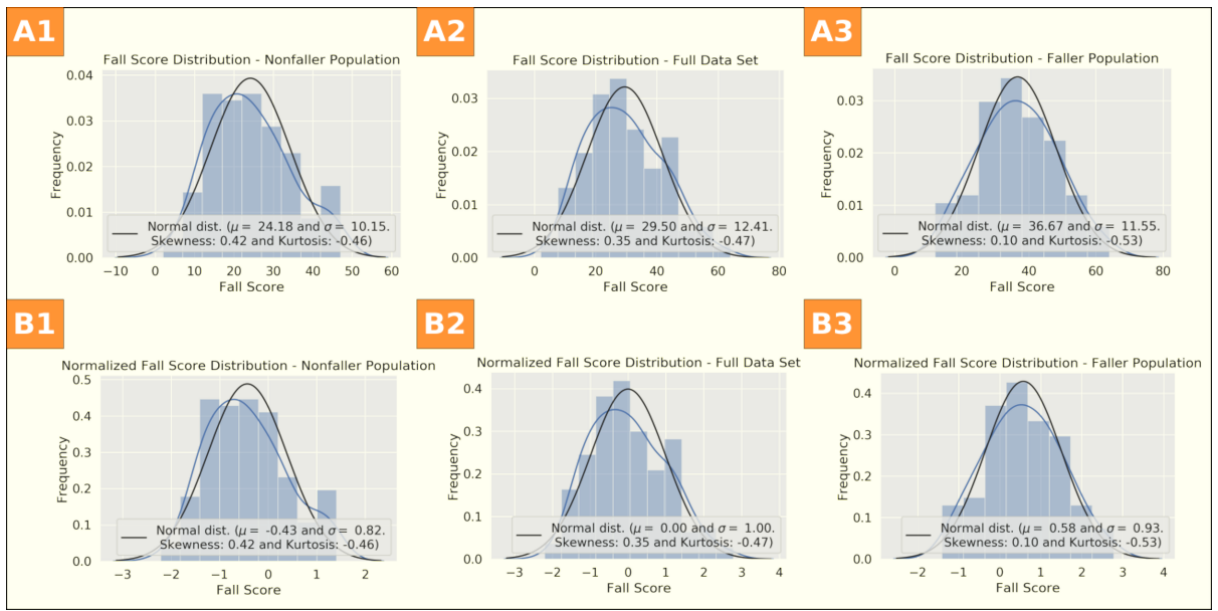
Figure 1. Fall-risk score histograms. Row A shows histograms for nonnormalized fall scores and Row B for standard-scaled fall scores. A1 and B1 show the nonfaller subgroup, A2 and B2 show the full dataset, and A3 and B3 show the faller